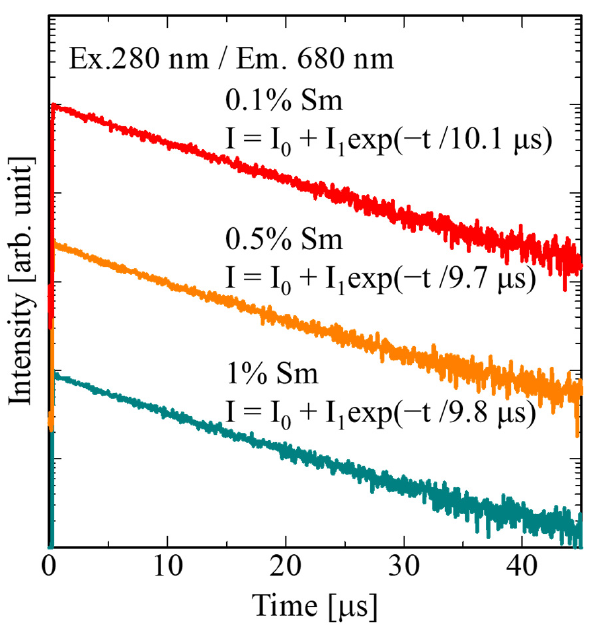
Figure 2. PL 3D spectrum of 0.1% Sm:SrCl 2 .